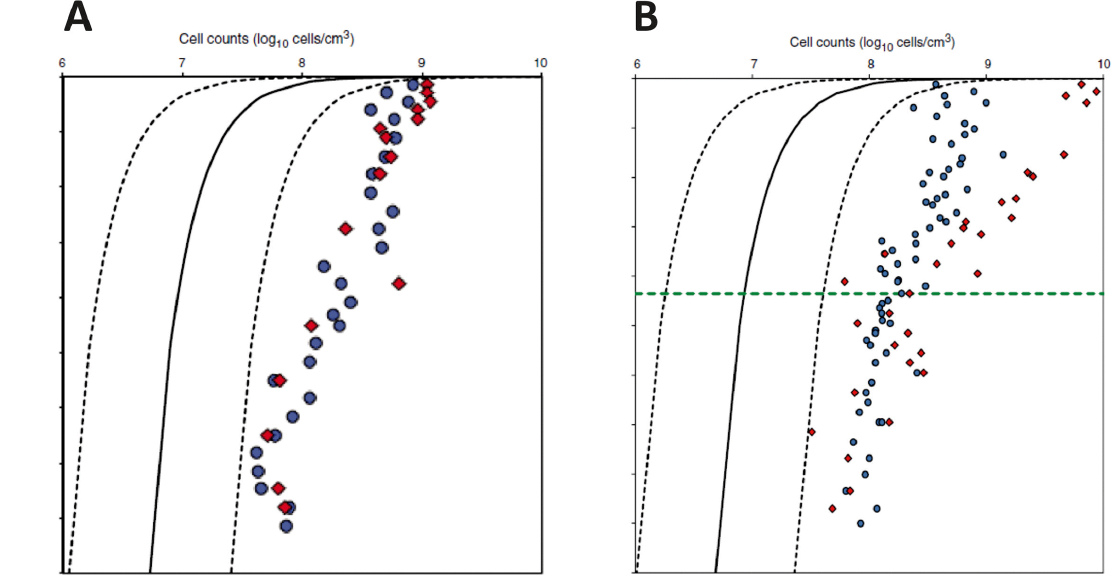
Figure 8. Cell numbers from (a) Little Belt, site M0059, and (b) the Landsort Deep, site M0063. Red diamonds: cell counts by fluorescence microscopy (AODC, acridine orange direct counts); blue circles: cell counts by flow cytometry. The solid black line is a global regression line of prokaryote cell numbers with depth, while the dashed lines are upper and lower 95% prediction limits for the regression line (Roussel et al.,